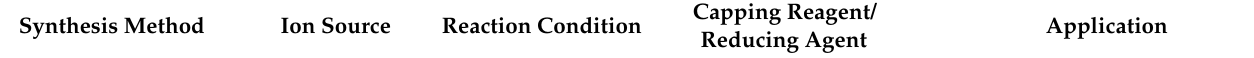
Table 5. Comparison of synthesis methods and application of various facet-dependent Cu 2 O.